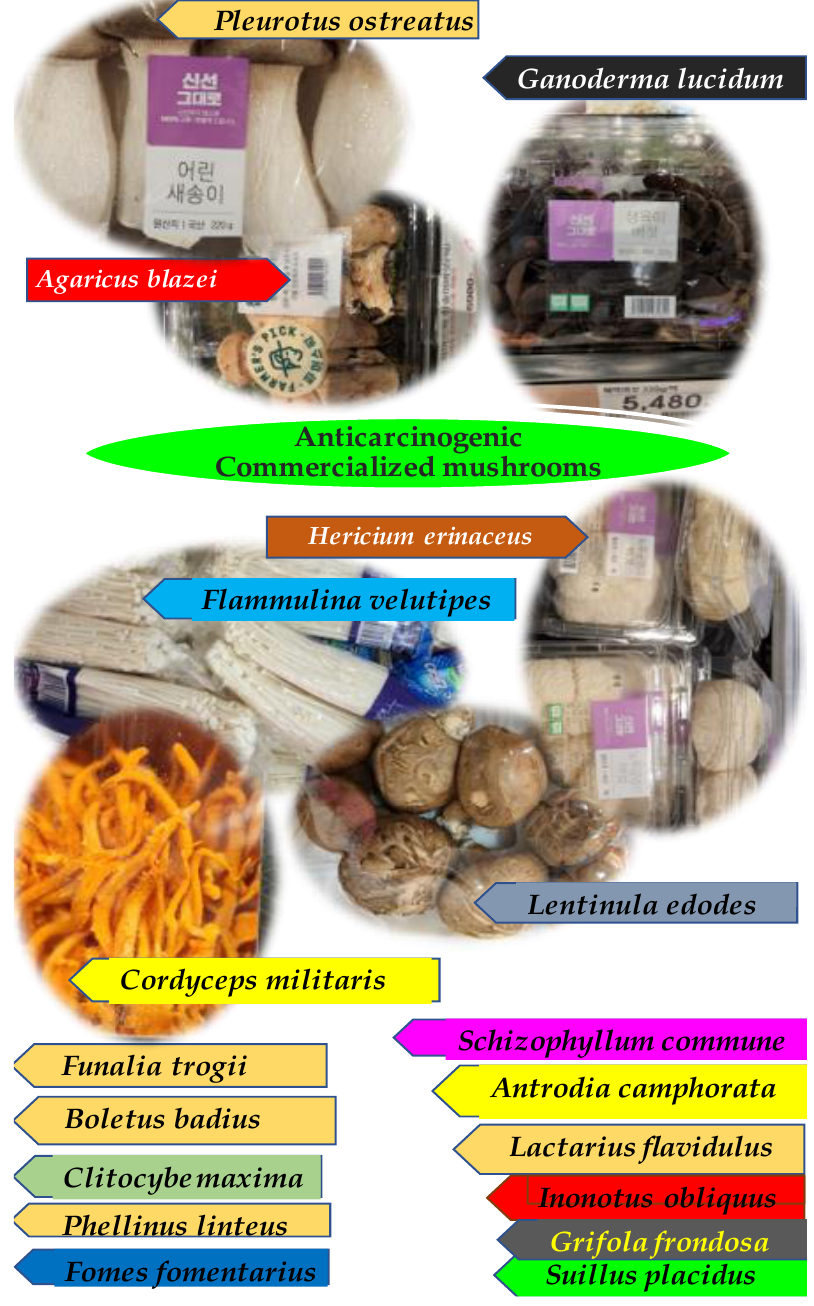
Figure 1. Snapshot of commercially available mushrooms in a traditional Asian market. Polysaccharides are structurally diverse class of versatile macromolecules [8]. Mushroom polysaccharides have been successfully applied in anticancer experiments. The extraction of mushroom polysaccharides starts with treating dried powdered mushroom with 80% ethanol to remove the low molecular weight substances. Crude fractions are further extracted with water, 1% ammonium oxalate and 5% sodium hydroxide. The extracted polysaccharides can be fractionally purified by the ethanol concentration, fractional precipitation, ion-exchange chromatography, gel filtration and affinity